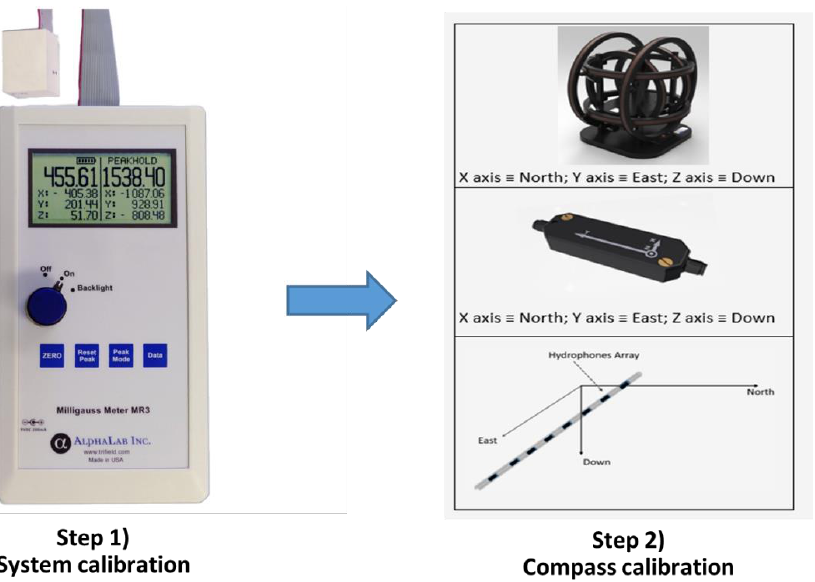
Figure 3. The two-step procedure needed to calibrate our set-up. Step ( 1 ) System calibration: the milli- gauss MR3 m is placed inside the tri-axial Helmholtz coil (HHC). Step ( 2 ) Compass calibration: the seg- ment of the towed hydrophone array (THA) where the compass is mounted is placed inside the